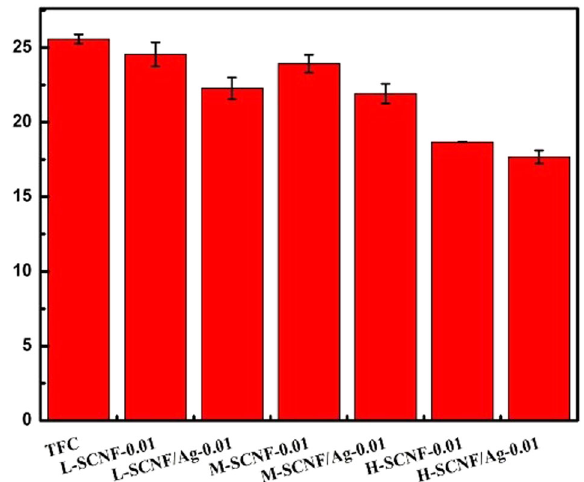
Fig. 6 Contact angle of composite nano fi ltration membrane. Error bars represent standard deviations using at least two measurements from two different samples.